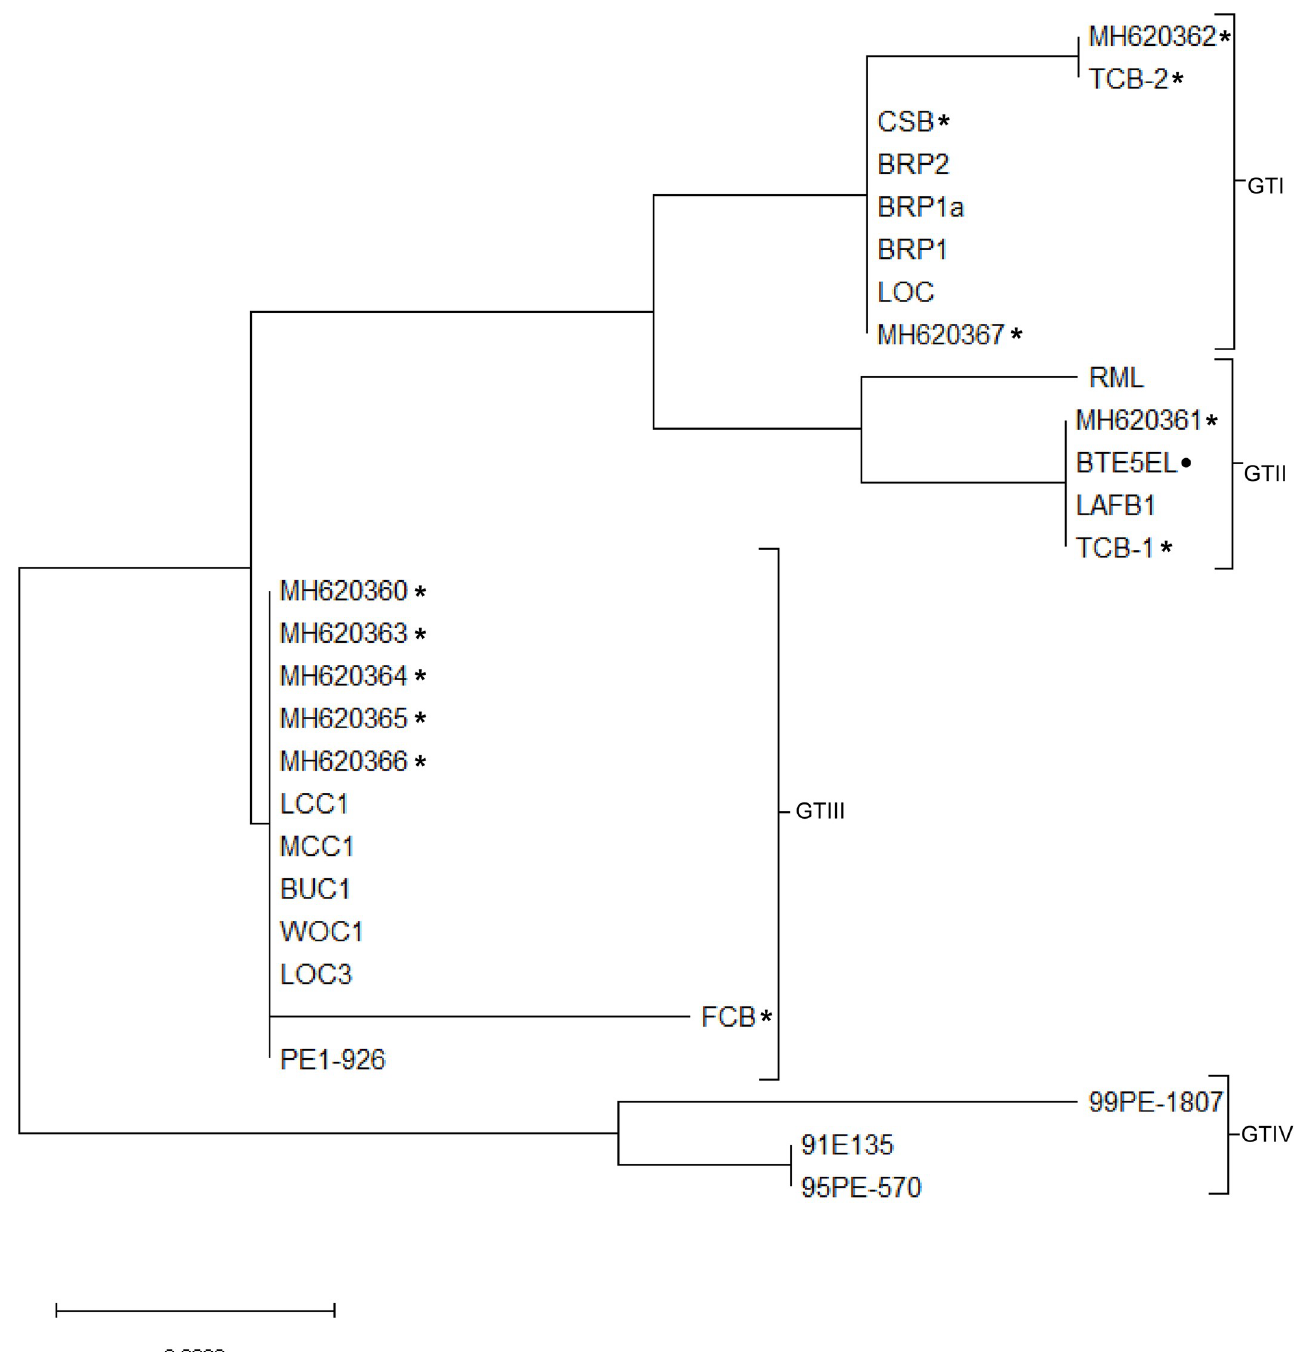
Fig 2. Phylogram of the intergenic spacer sequences from Borrelia turicatae . Sequences were obtained from infected canines ( � ), a human (•), and all others B . turicatae IGS sequences originated from infected ticks. The phylogenetic tree was generated with 1,000 bootstrap replicates. The scale bar for branch lengths represents the number of nucleotide substitutions per site (0.0020).